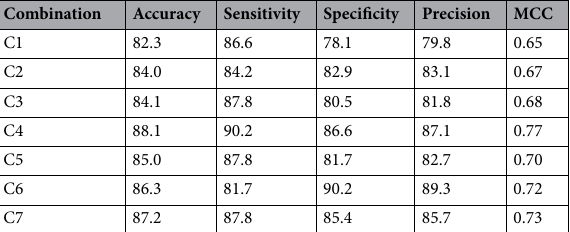
Table 8. Results achieved using independent test for ACP-500/164 dataset (Complete sequences utilized instead of 15 N-terminus amino acids). Model trained on ACP-500 and tested on ACP-164.